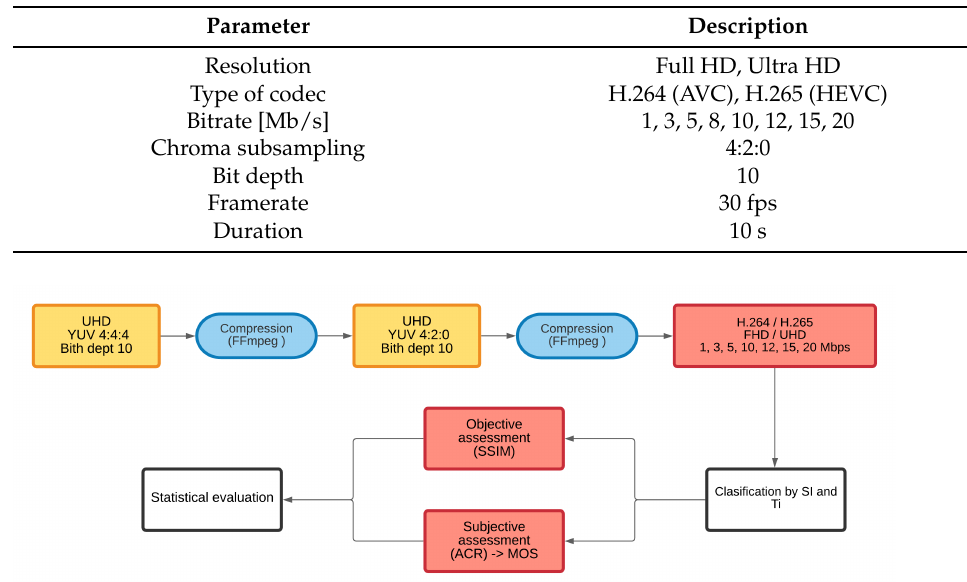
Figure 1. The process of coding, classification, and evaluation of quality.